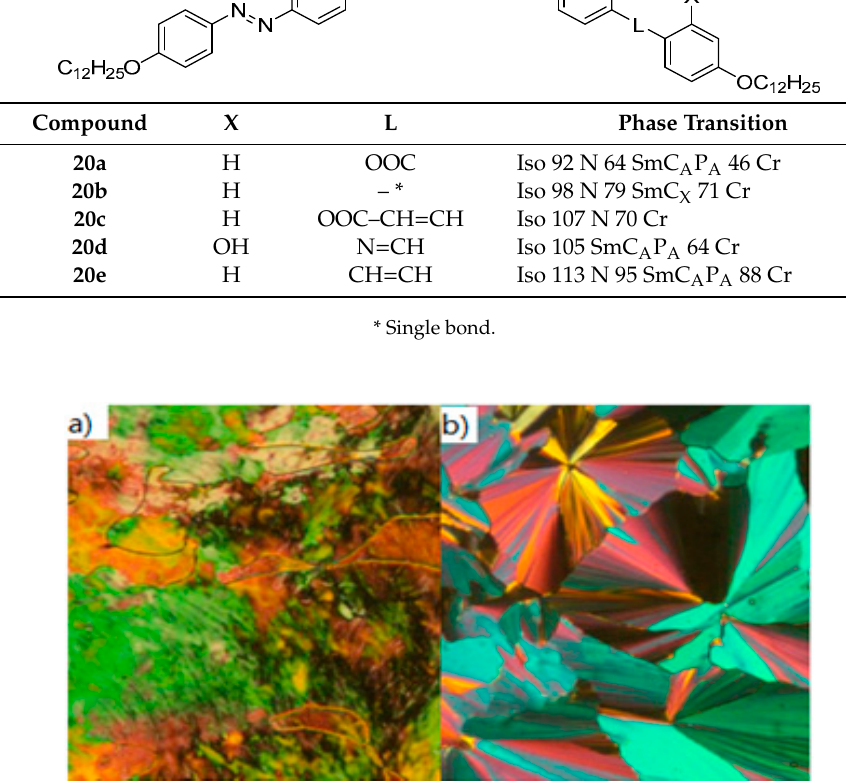
Figure 6. Optical texture for 20b in ( a ) the nematic phase at T = 90 °C and ( b ) the unidentified SmC x phase at T = 75 °C. (Reproduced with permission from ref. [110], copyright Elsevier 2020, https://doi.org/10.1016/j.molliq.2020.112743).